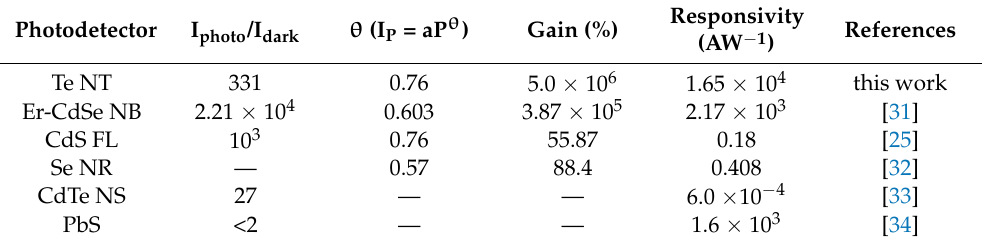
Table 1. Comparison of the spectral responsivity, the photoconductivity gain, I photo /I dark and non- unity exponent θ of the Te NT with previous reported work.